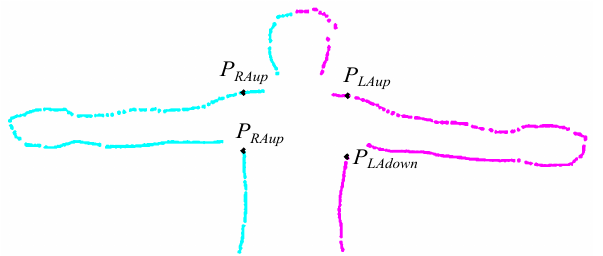
Figure 4. The contour points of the upper body determined using the Concave Hull method projected onto the XY